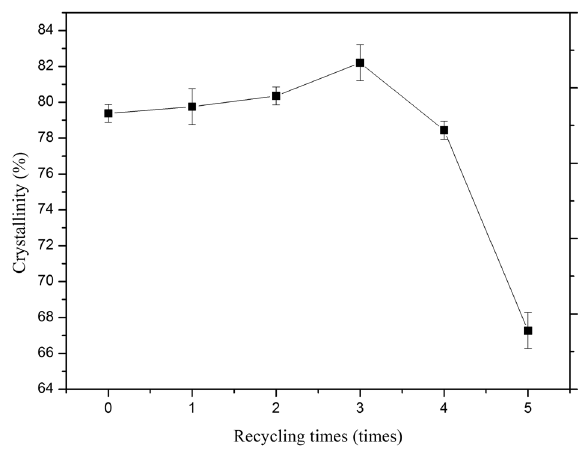
Figure 4: Changes in the extent of crystallinity of hydrolyzed cellulose under a varied number of waste liquid